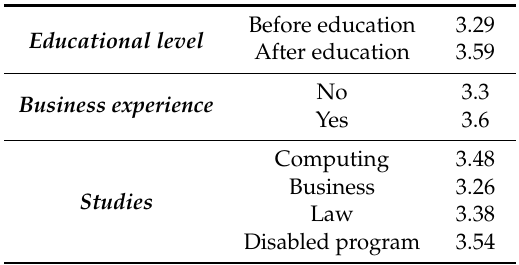
Table 5. Mean ATE test